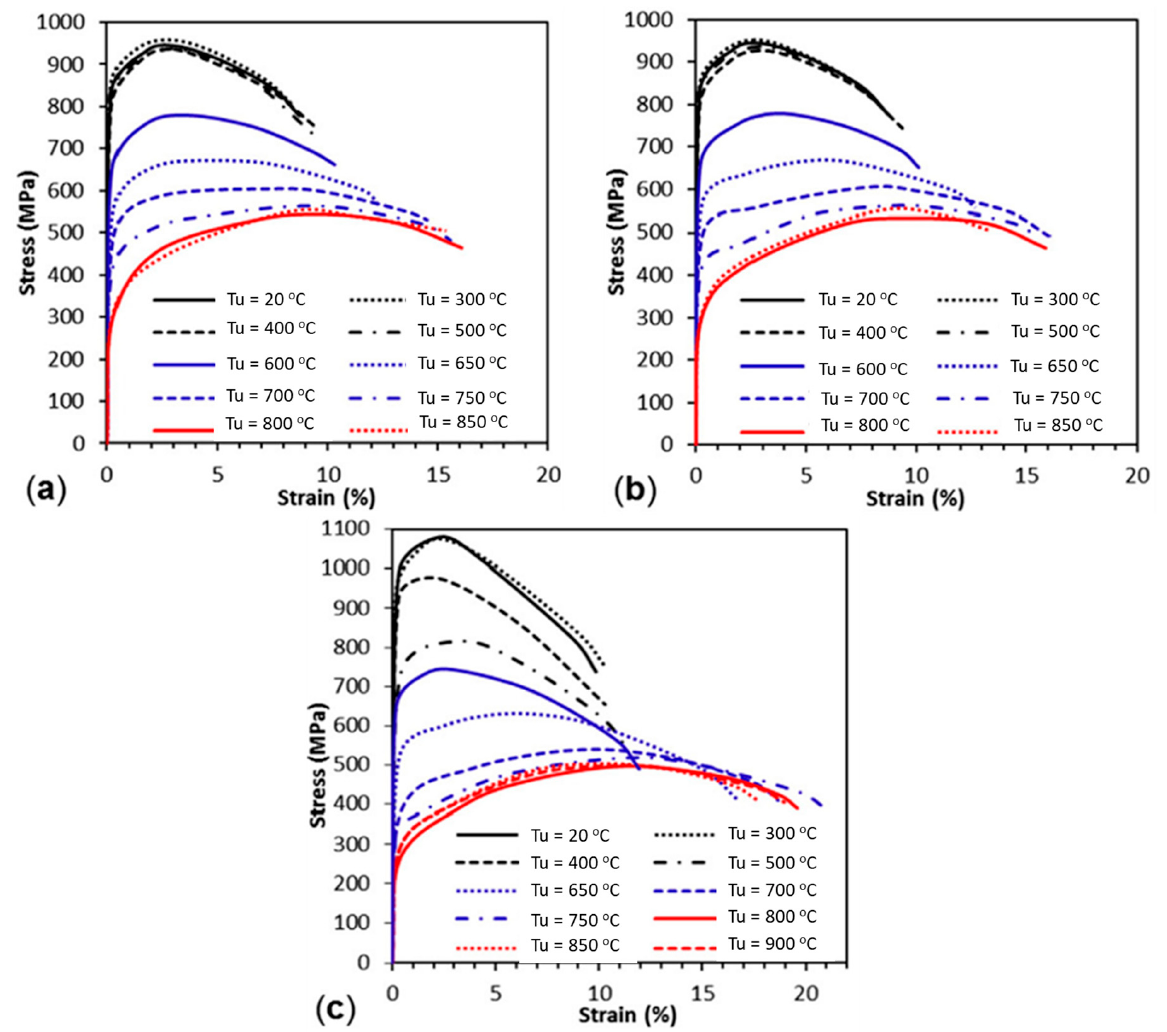
Figure 7. Residual stress–strain response of high-strength bolts subjected to high temperatures ( a ) M16 (10B38), ( b ) M18 (10B38), ( c ) M22 (10B21) bolts [88].